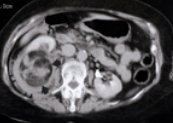
FIGURE 1 . Contrast enhanced CT shows fat containing mass (arrows) arising from mid portion right kidney (note residual parenchyma (curved arrows)). Soft tissue density strands surround the mass and the kidney, typical of